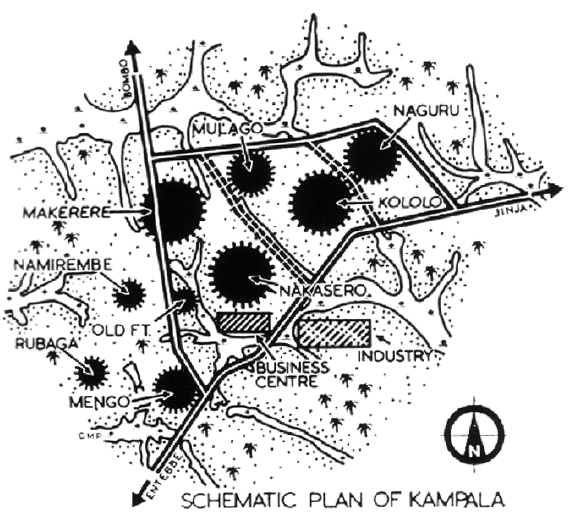
Figure 12. Schematic Plan of Kampala. Source: May (1947).